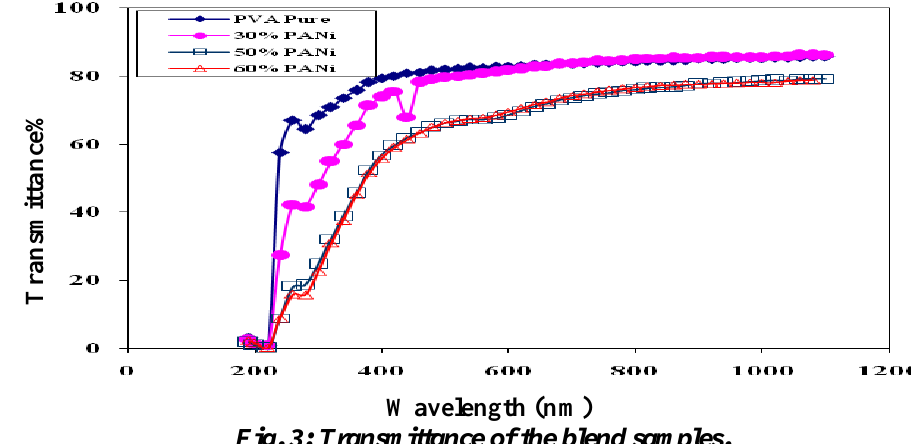
Fig. 3: Transmittance of the blend samples.